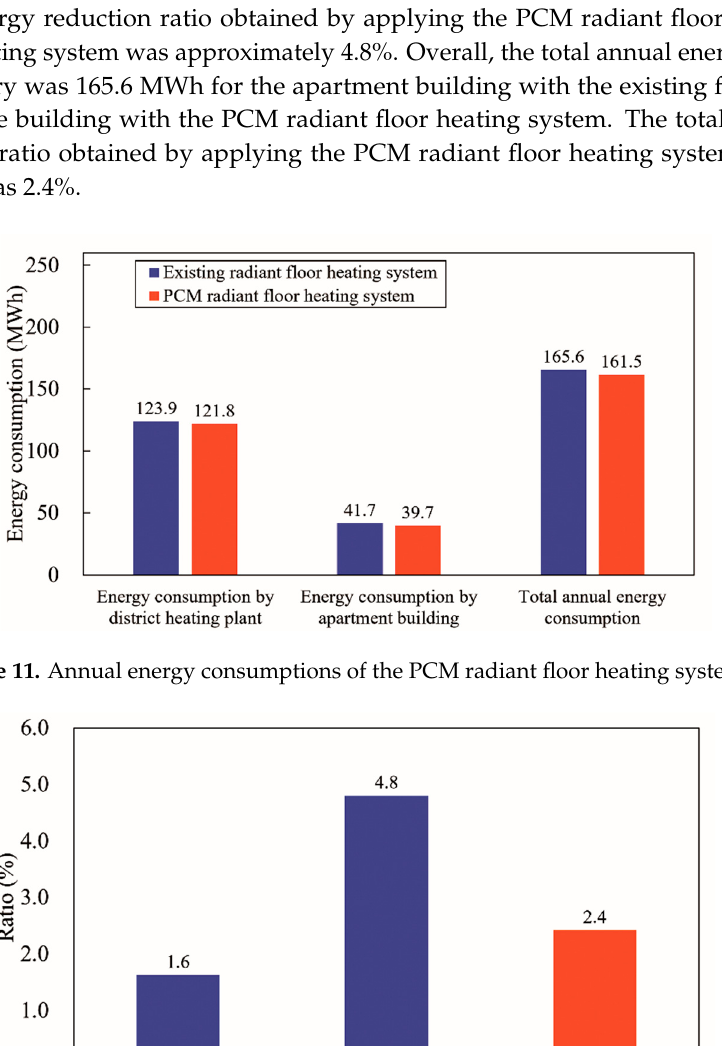
Figure 10. Floor surface temperatures on the second stories of the apartment buildings. 259